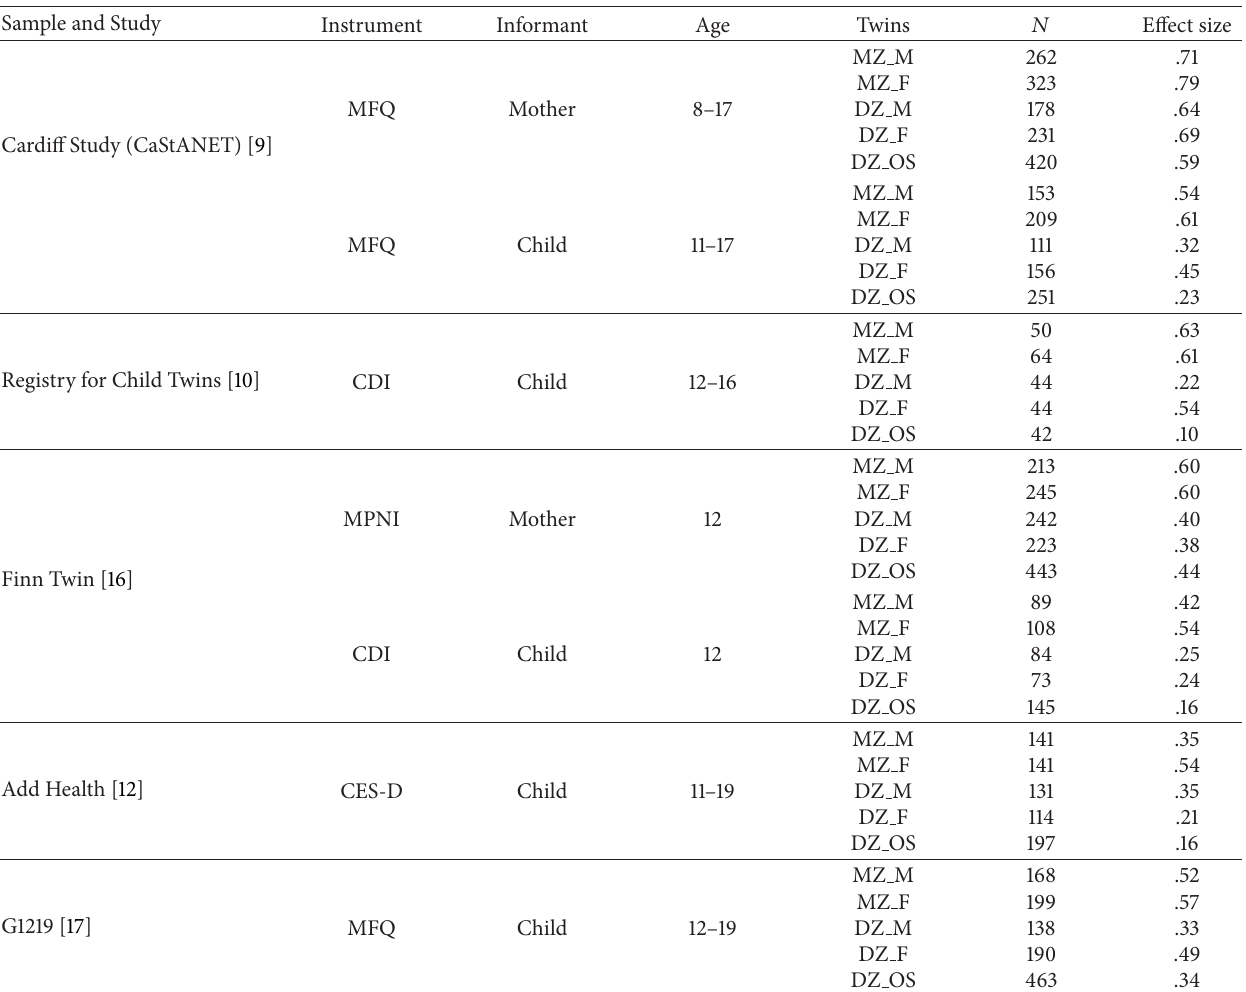
Table 1: Studies included in the